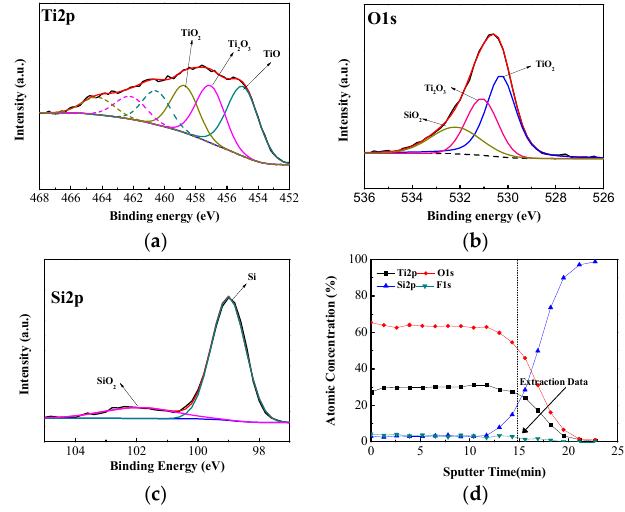
Figure 2. ( a ) Ti 2p; ( b ) O 1s; ( c ) Si 2p core level atomic structures for LPD ‐ TiO 2 obtained through